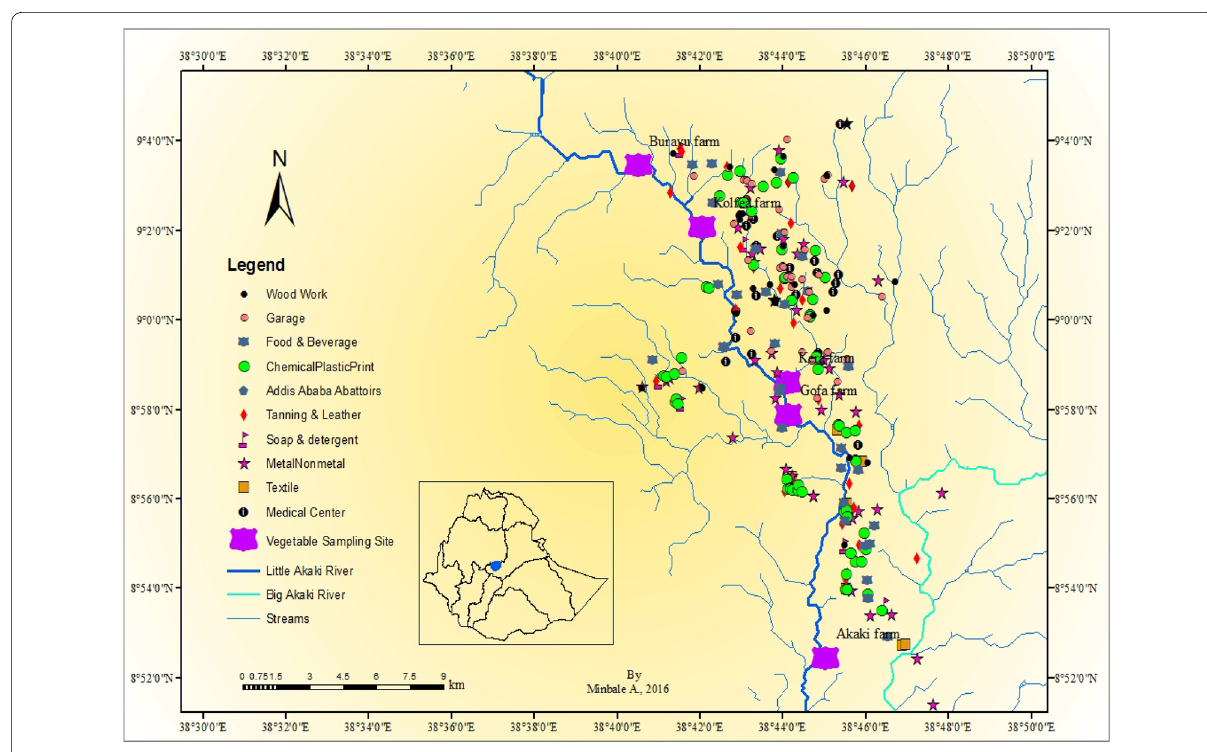
Fig. 1 Sampling sites of the study area in Addis